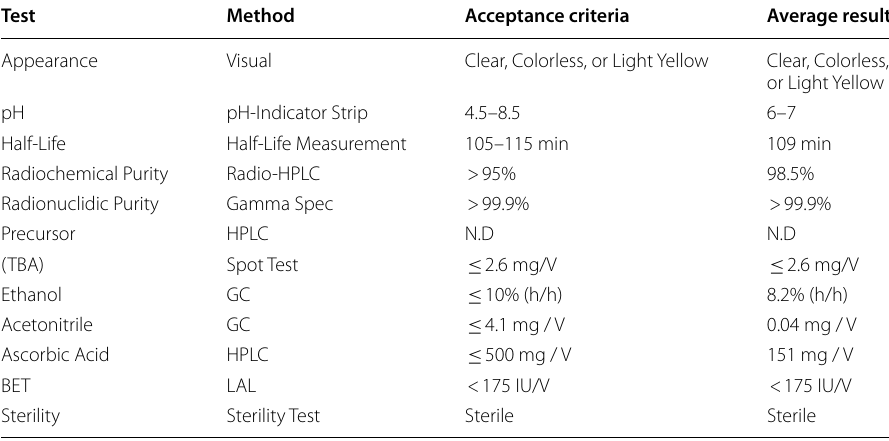
Table 4 Final product specifications of [ 18 F]Flurpiridaz ( 7